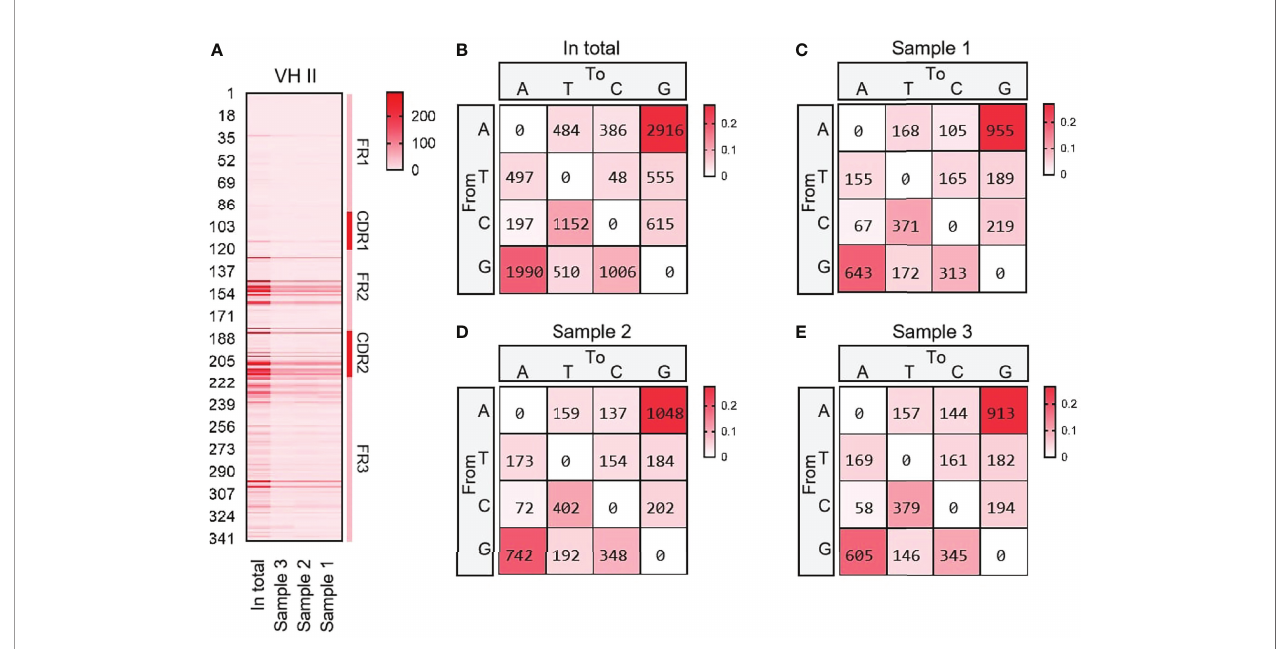
FIGURE 4 | The somatic hypermutation (SHM) of yak IgH. (A) The distribution of SHM in yak IgH; (B – E) The base mutation types of SHM in yak